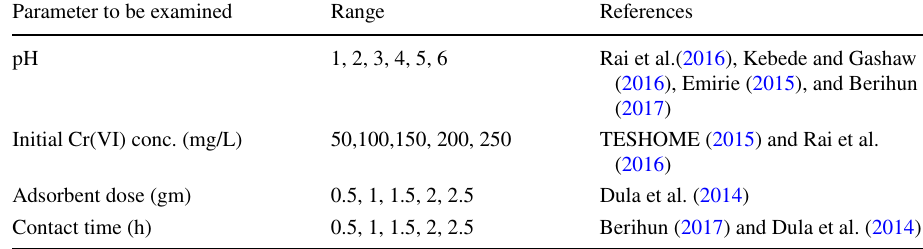
Parameter to be